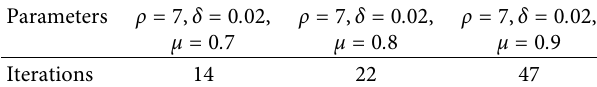
Table 1: Algorithm 1 (numerical results). Parameters